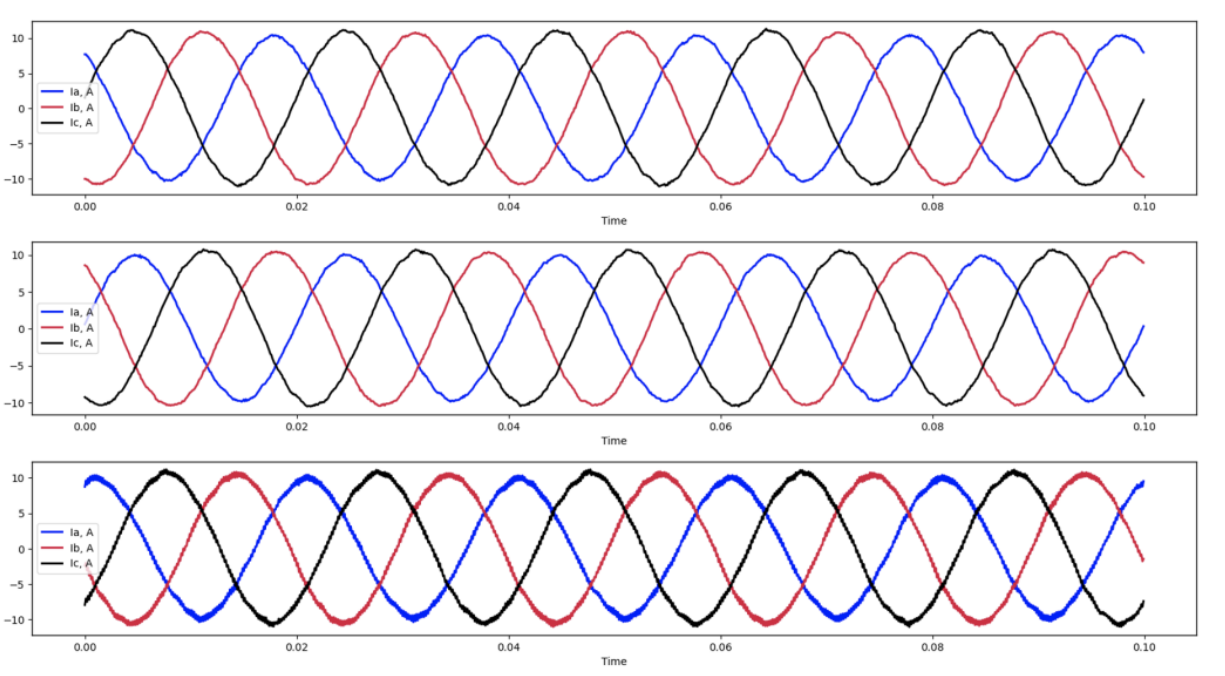
7 of 24 Figure 2. Bearing 6208 ZZ C3. Table 2. Bearing data sheet. Bearing